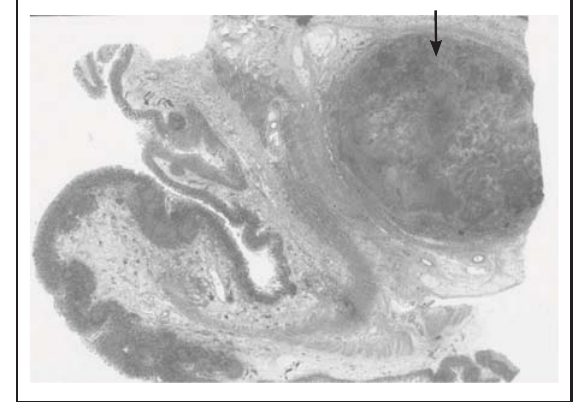
Figure 1. Section of ileocaecal region showing a lymph node on the mesentery (arrowed) involved with KFD.